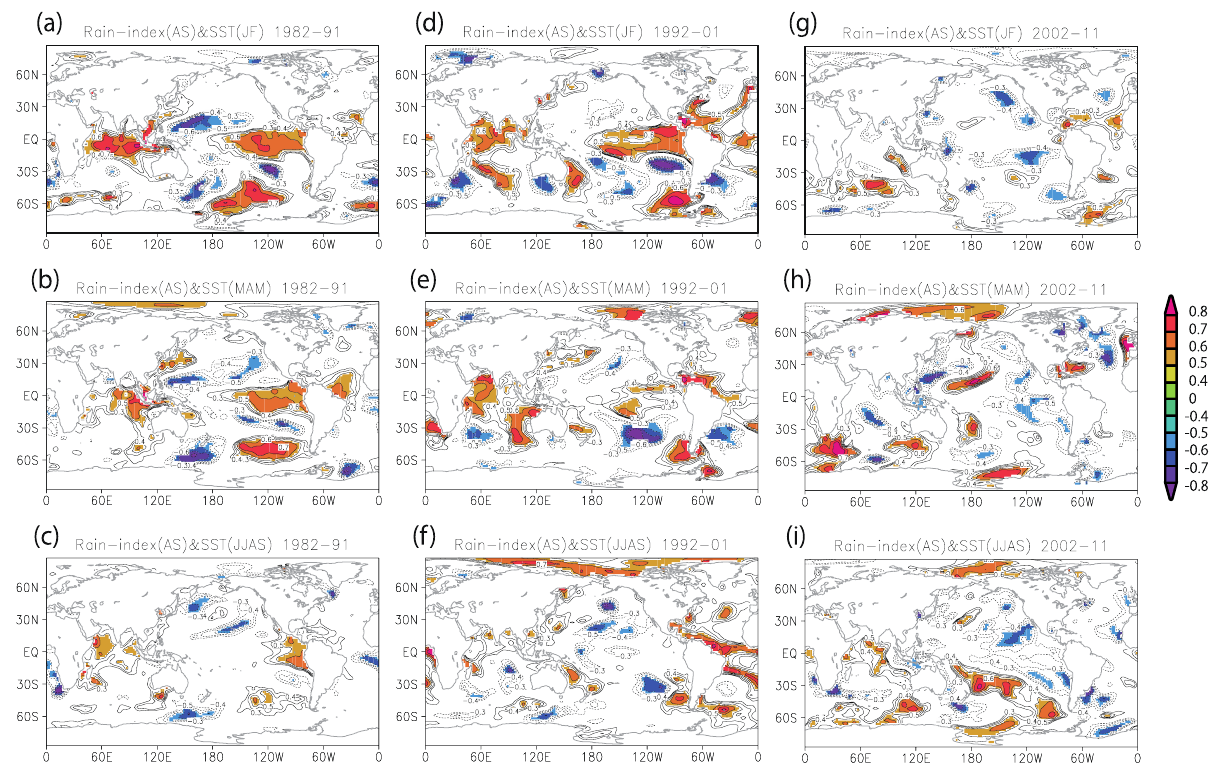
Figure 6. Changing relationship of lagged correlation between SST and rainfall over northern India. Correlation maps between August–September (AS) rainfall variability over northern India (20–30° N, 75–90° E) and ( a ) two-season lead January–February (JF) SST anomaly, ( b ) one-season lead March–May (MAM) SST anomaly, and ( c ) simultaneous June–September (JJAS) SST anomaly during 1982–1991. ( d – f ) same as ( a – c ) but for 1992–2001. ( g – i ) same as ( a – c ) but for 2002–2011. Only areas above 90% significance are shown. Contour intervals are 0.1 (less than ± 0.3 are omitted).